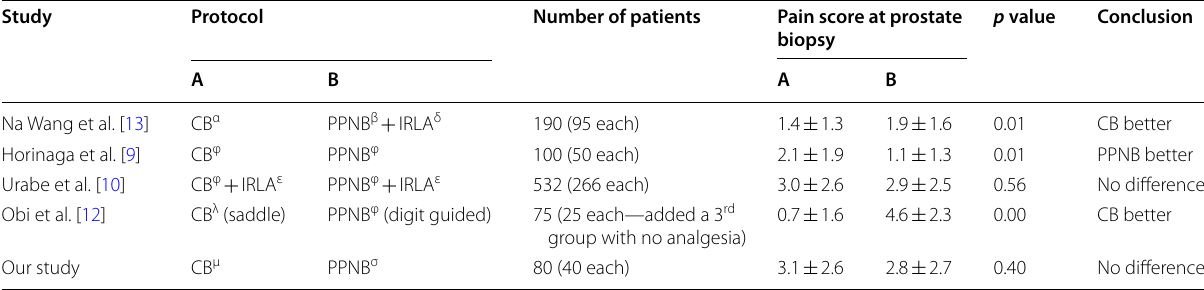
Table 4 Protocols, findings and conclusions of studies that compared CB with